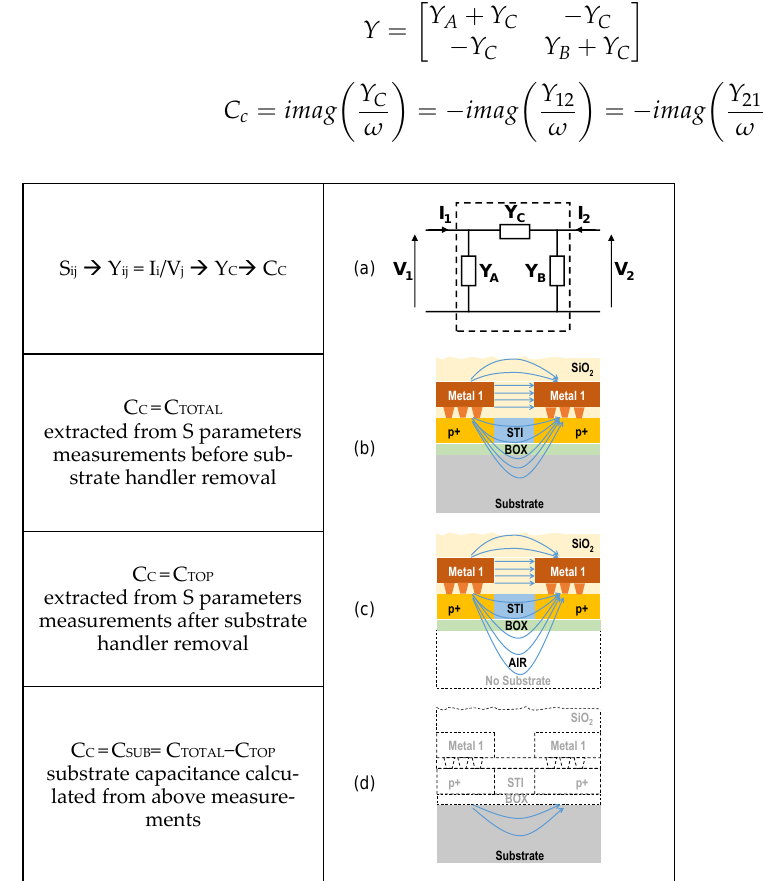
Figure 4. Extraction of capacitive coupling between interdigitated electrode combs. ( a ) Principle of extraction of coupling admittance Y C from the measured admittance matrix Y ij ; ( b ) extraction of coupling capacitance C TOT ; ( c ) extraction of capacitance C TOP after local substrate removal; ( d ) deduction of the substrate coupling capacitance.